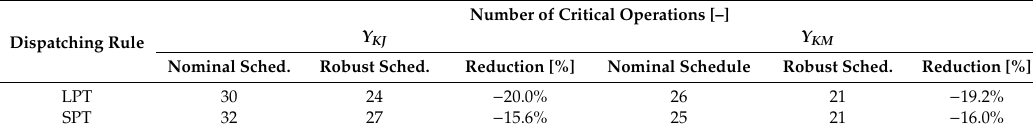
Table 8. The number of critical operations in the nominal and robust schedules.